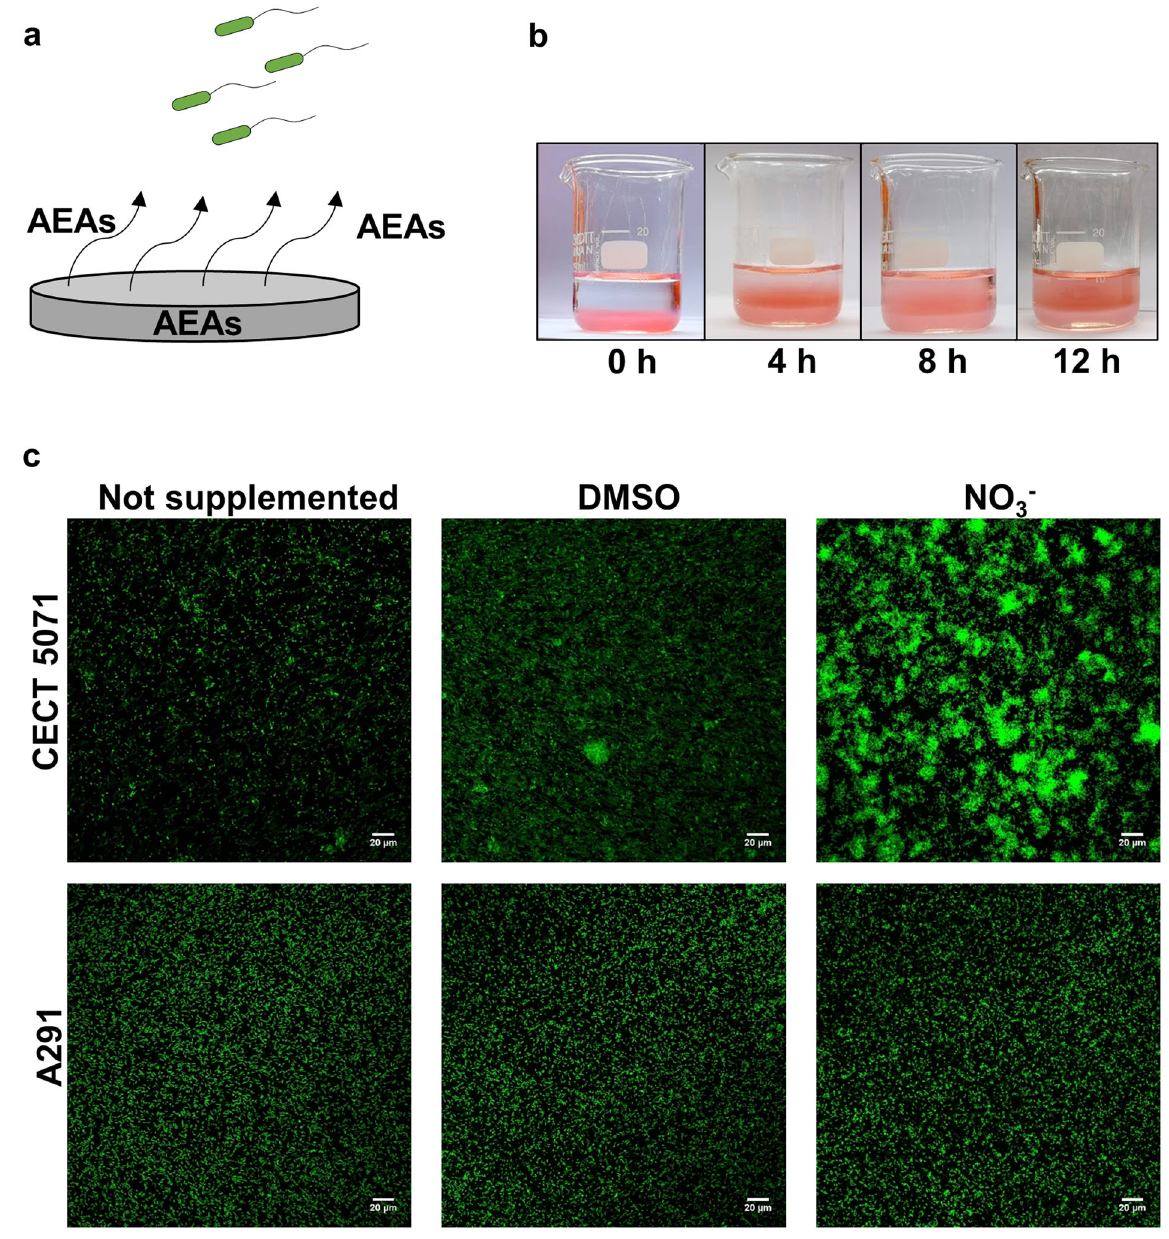
Fig. 3 Electron acceptors promote strain-speci fi c bio fi lm formation of S. algae . a Experimental set-up to assess bio fi lm formation by S. algae . Alternative electron acceptors (AEAs) were incorporated into ultra-pure agarose, from which they are progressively released. b Visualization of AEA release from agarose. Shown is a recipient with agarose containing cobalt (II) nitrate that is overlaid with water. c Surface colonization patterns of S. algae CECT 5071 and S. algae A291 on agarose plugs containing either no AEAs or 35 mM of the selected AEAs DMSO or sodium nitrate visualized by Confocal Laser Scanning Microscopy after staining with the BacLight viability kit. Representative images are